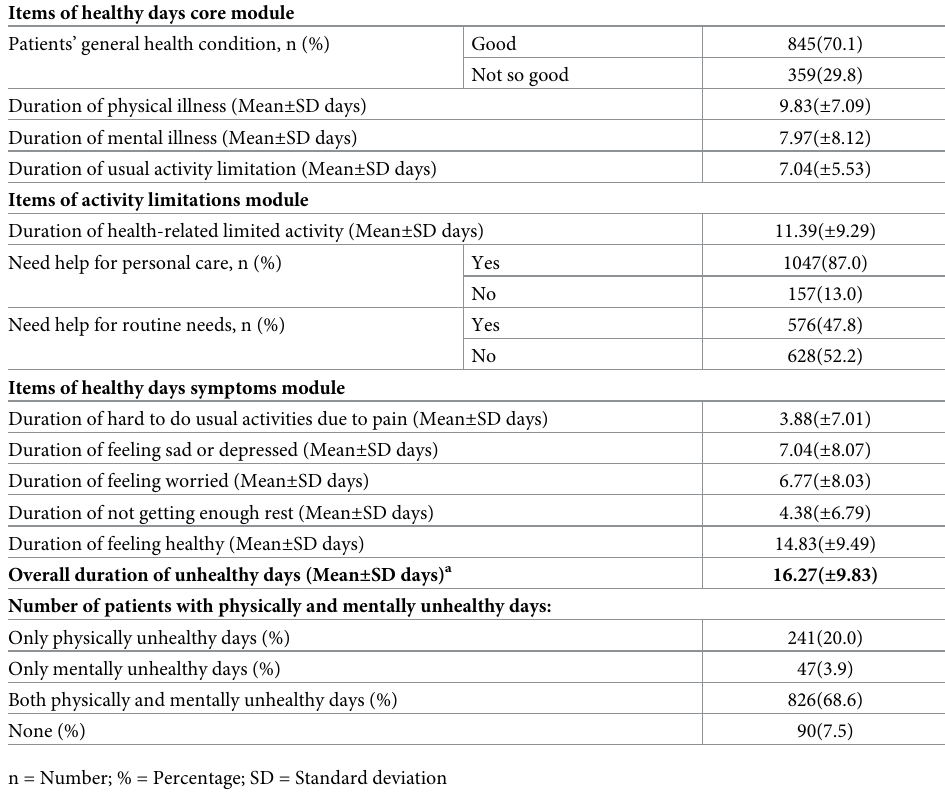
Table 2. Distribution of different items of health-related quality of life of the COVID-19 patients (based on CDC HRQOL-14). Items of healthy days core